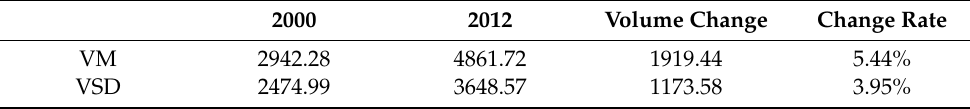
Table 5. The changes of VM and VSD from 2000 to 2012 (m 3 ).